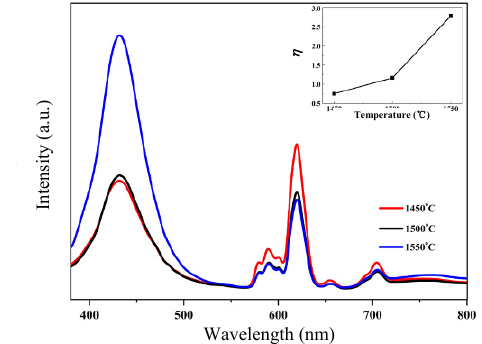
Fig. 9 PL spectra and dependence of η on the synthesis temperature (1450 ℃ , 1500 ℃ , 1550 ℃ ) of Ba 0.79 Al 10.9 O 17.14 : 0.04Eu for 4 h.